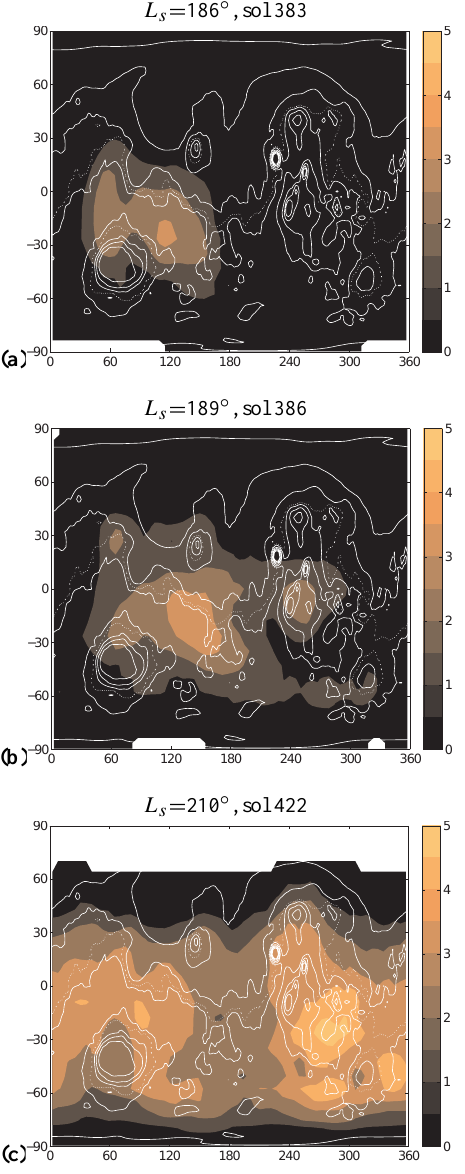
Fig. 2. Instantaneous plots of (equivalent visible) dust optical depth at the reference pressure of 610Pa assimilated at model resolution. (a) L s = 186 ◦ (sol 383 from the beginning of the Martian year), (b) L s = 189 ◦ (sol 386), and (c) L s = 210 ◦ (sol 422) during the ini- tial stage of the 2001 planet-encircling dust storm. White contours represent topography with solid, dotted and dashed lines indicat- ing contours above, at and below the reference areoid, respectively. Blank patches indicate regions where data is